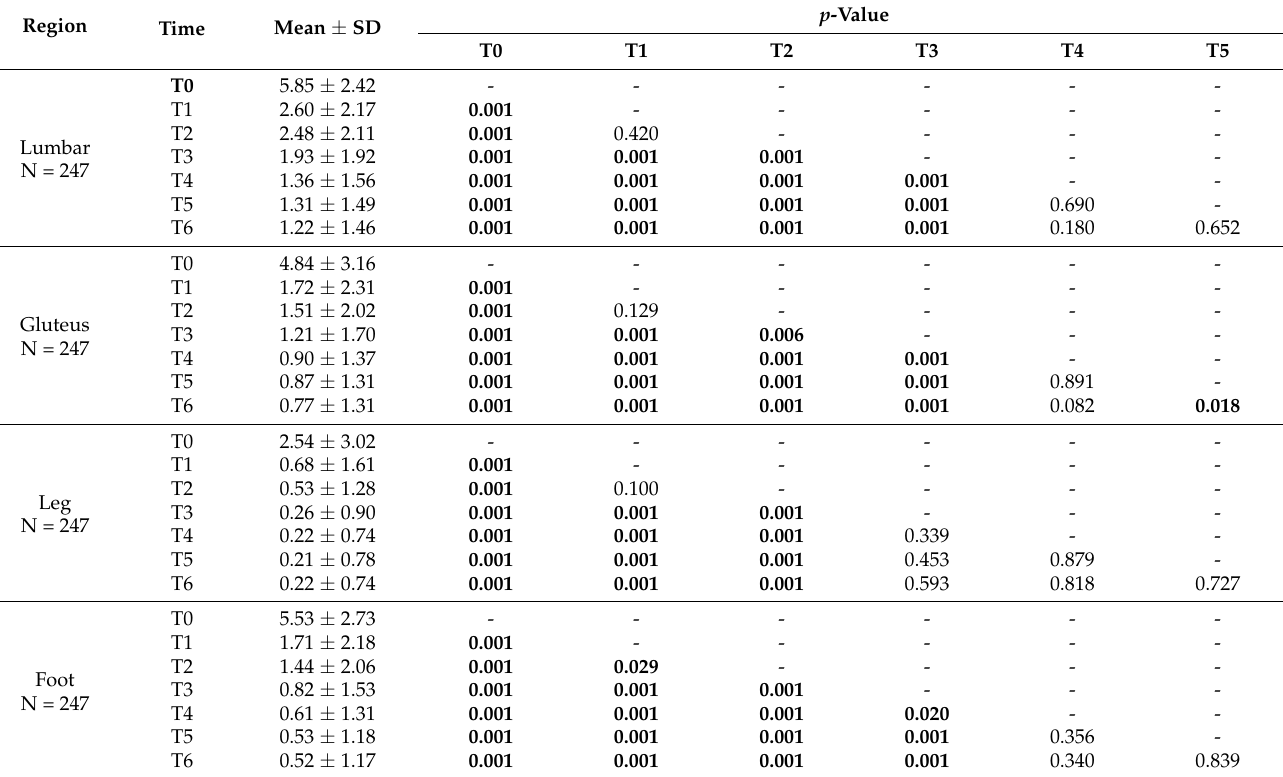
Table 2. Comparison of VAS values by region over the preoperative time (T0), 2 days (T1), 1